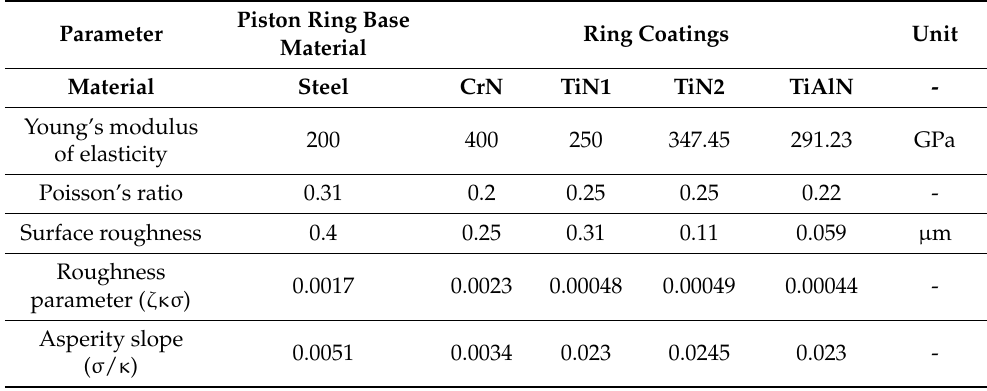
Table 4. Coating properties and surface topographical parameters for piston rings.